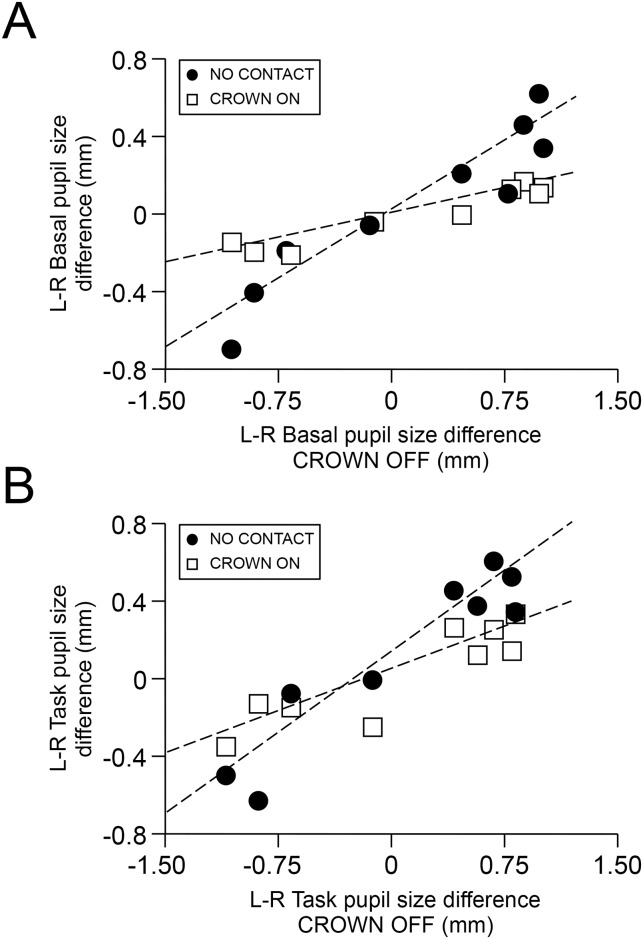
Relations between left-right pupil size difference in different conditions.Dots and open squares represent the left-right pupil size differences recorded in NO CONTACT and CROWN ON condition respectively, plotted as a function on the corresponding values obtained in the CROWN OFF condition. A. Basal pupil size asymmetry. B. Task pupil size asymmetry. Dotted lines are the regression lines obtained for dots and open square data, which correspond to the following equations: A. dots: r = 0.941, P<0.0005, Y = 0.468X + 0.18; squares: r = 0.958, P< 0.005, Y = 0.167X + 0.001. B. dots: r = 0.945, P<0.0005, Y = 0.666X–0.027; squares: r = 0.8878, P< 0.001, Y = 0.345X–0.036.